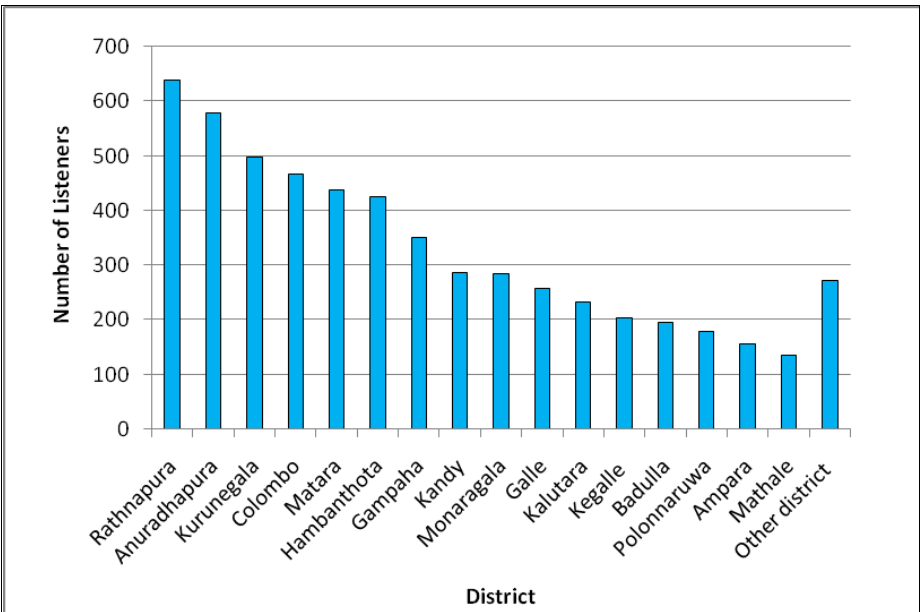
Figure 1 Mobile phone intervention : listeners by district